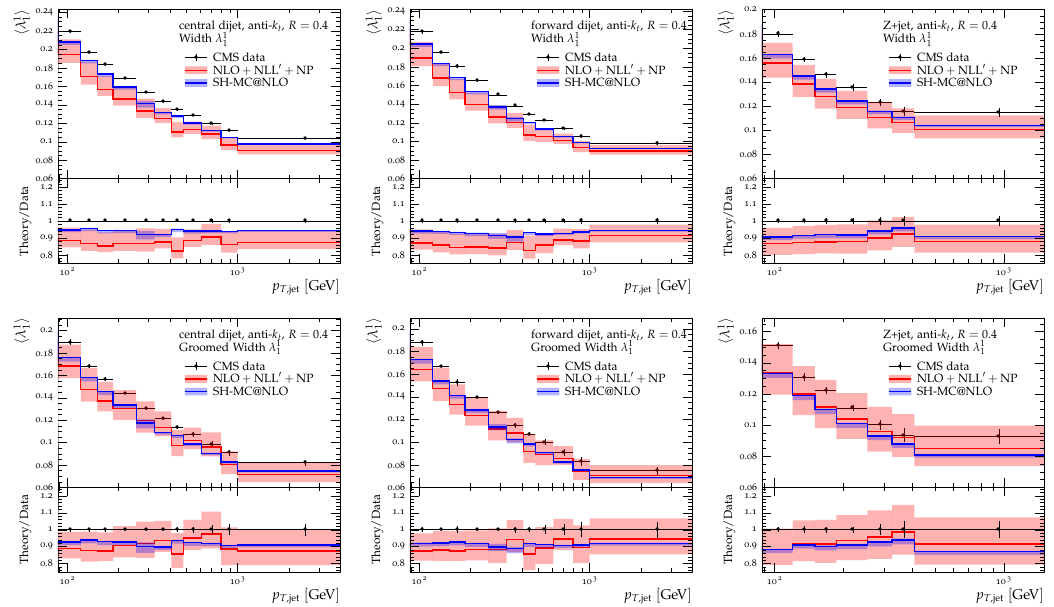
Figure 14. Mean values of jet width, i.e. h λ 1 i , for ungroomed (top row) and groomed (bottom row) 1 R = 0 . 4 anti- k t jets in dependence of p T, jet . The left and middle panel correspond to the central and forward jet in dijet events, respectively, the right one to the leading jet in Z +jet